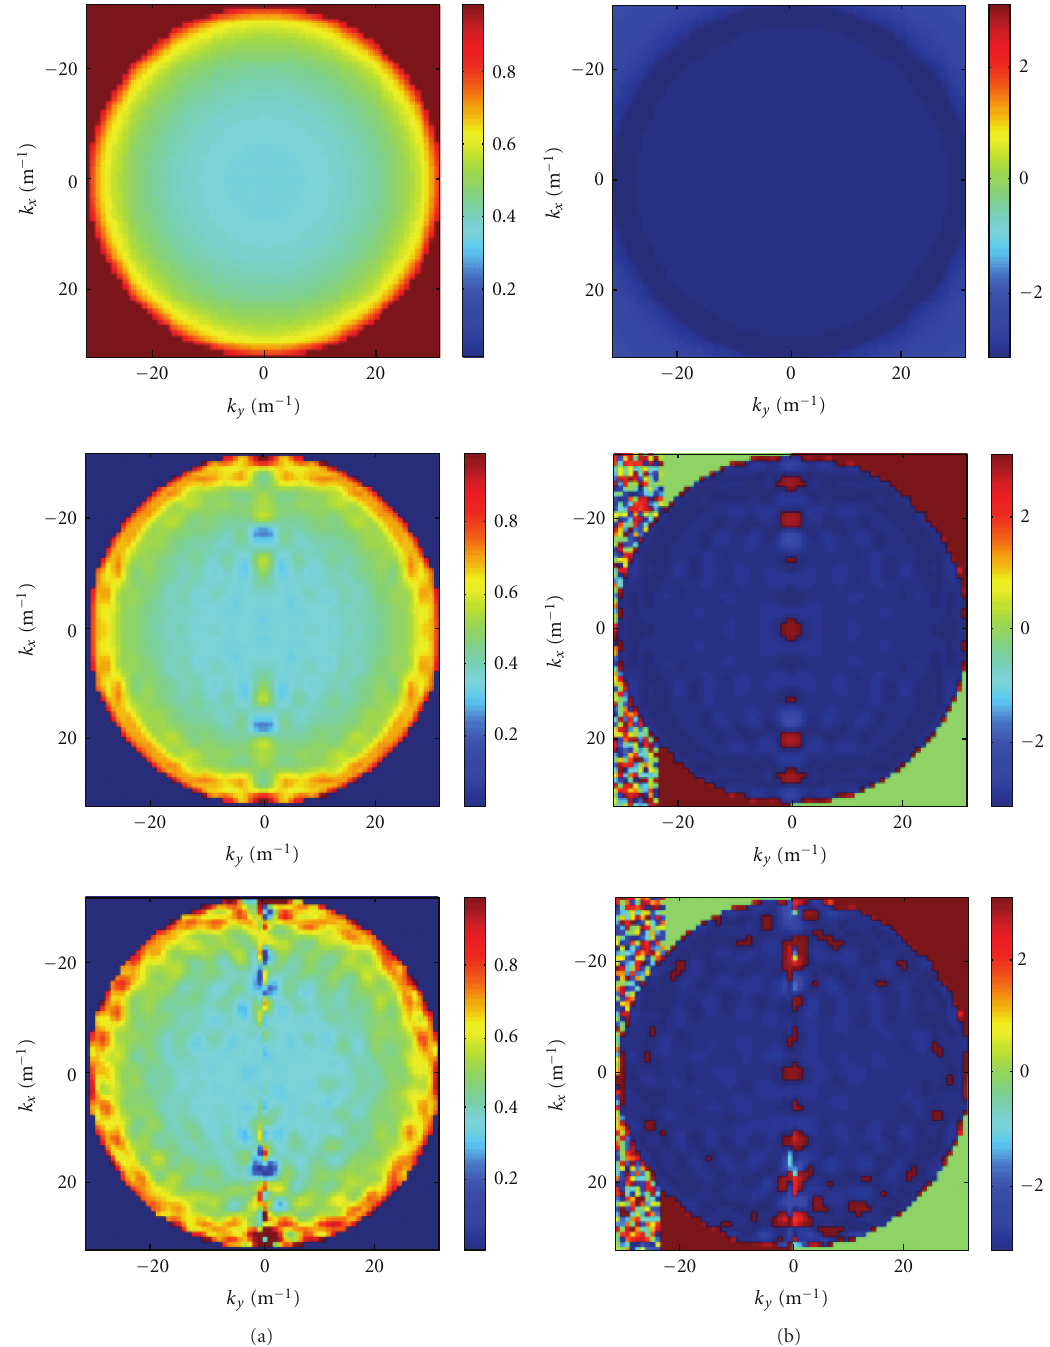
Figure 6: Soil 2. Amplitude (a) and phase (b) of Γ TE . Top line: actual values; middle line: noiseless estimation; bottom line: noisy